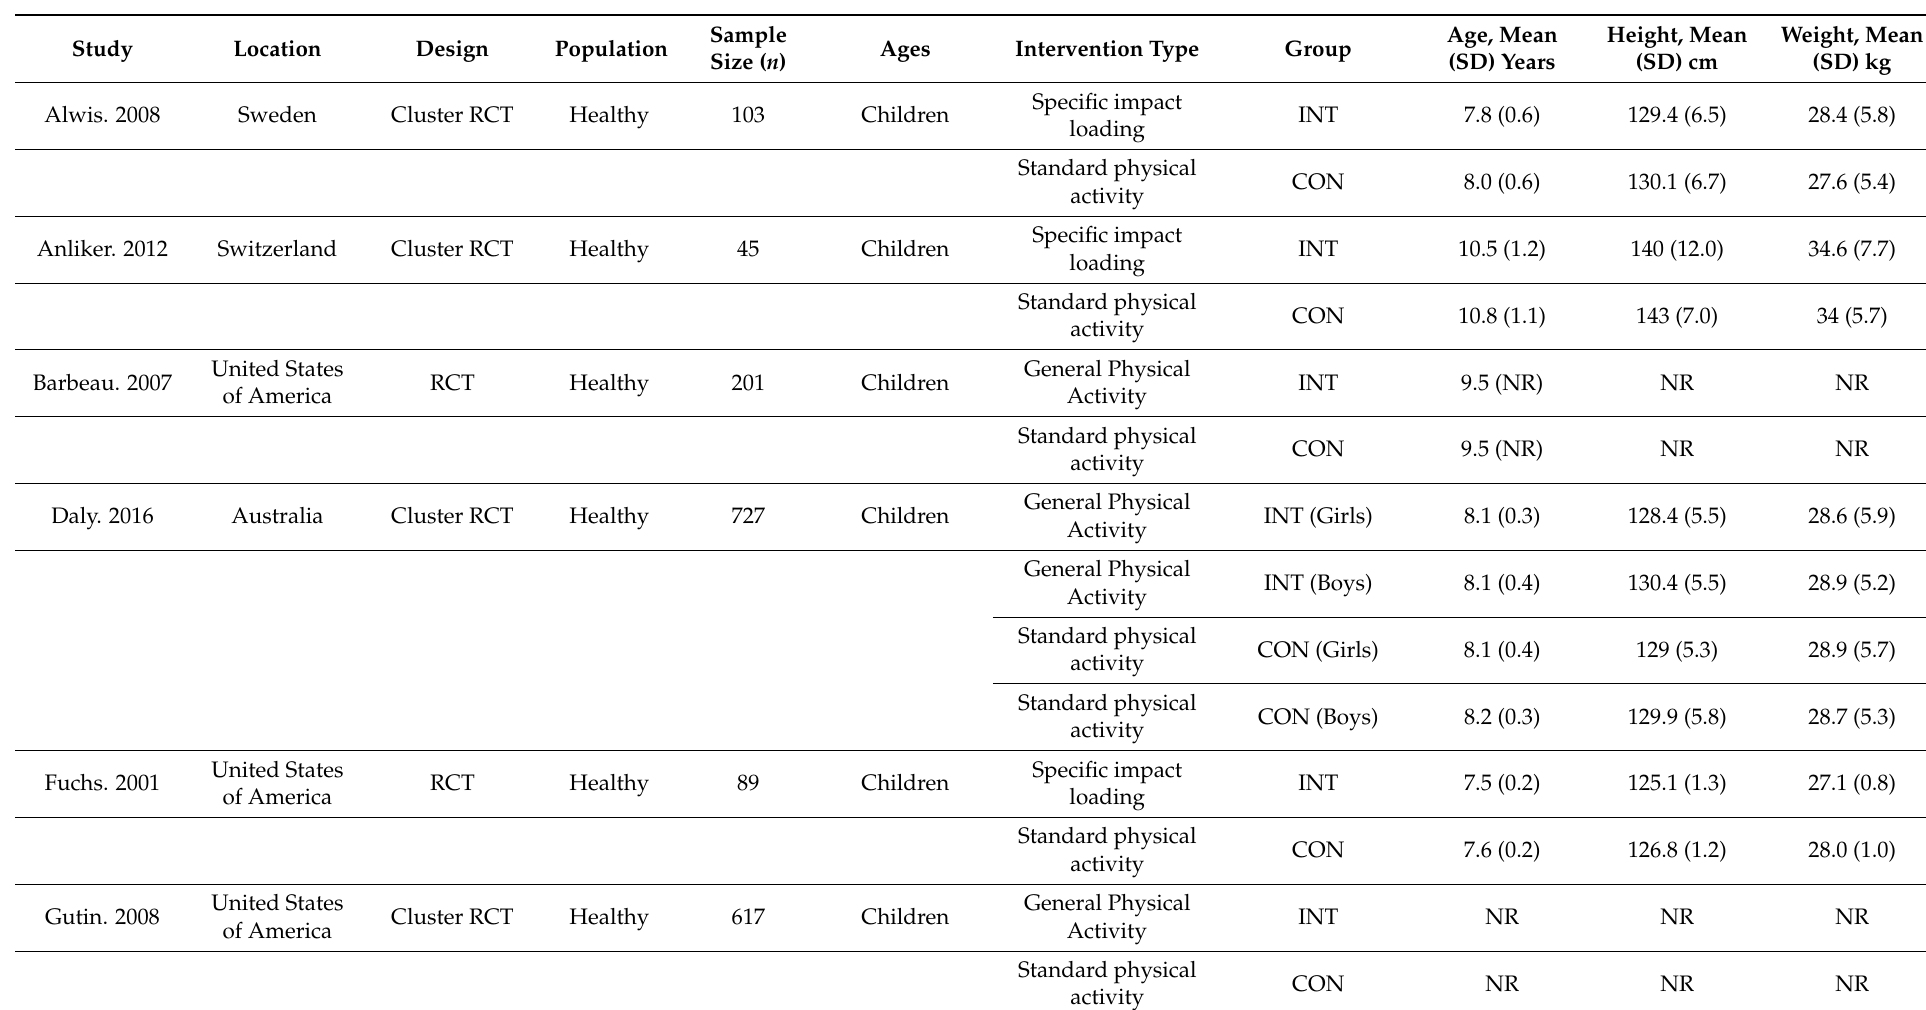
Table 1. Summary of included